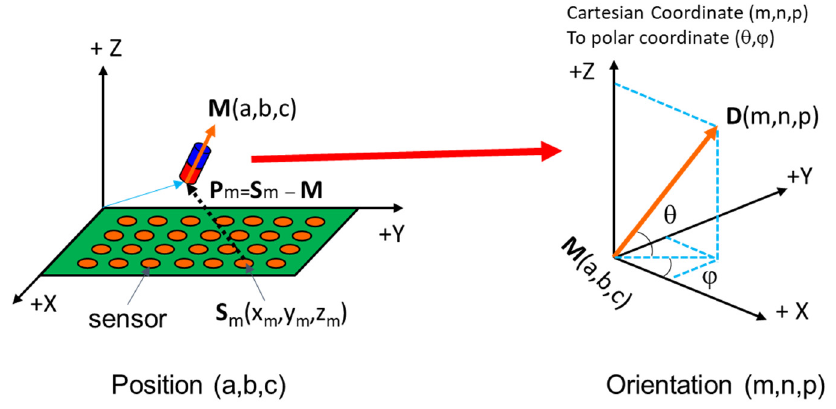
Figure 4. Schematic of a localization system with defined position and orientation of capsule’s mag- net.